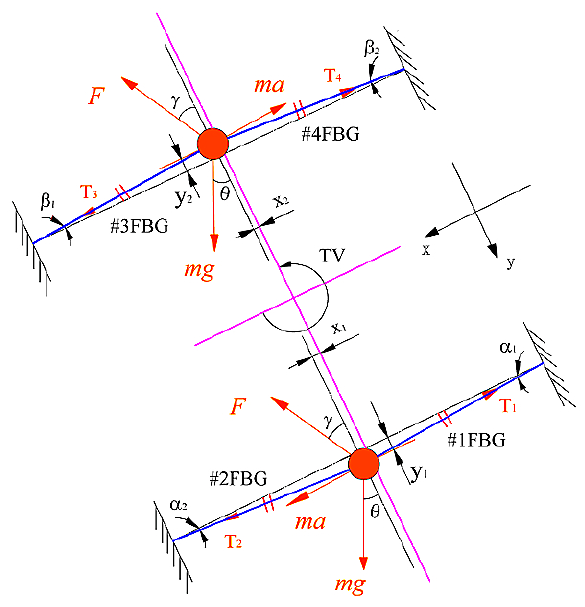
Figure 2. The force diagram of the mass ball optical fiber systems of the sensor.